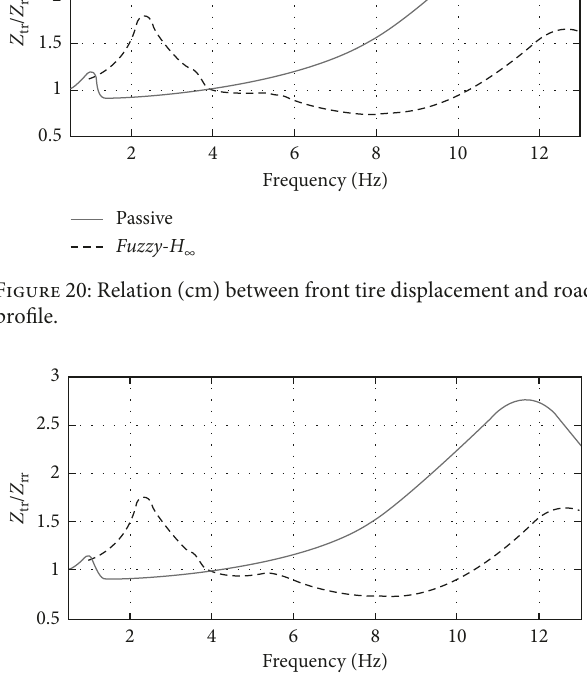
Figure 21: Relation (cm) between rear tire displacement and road profile.